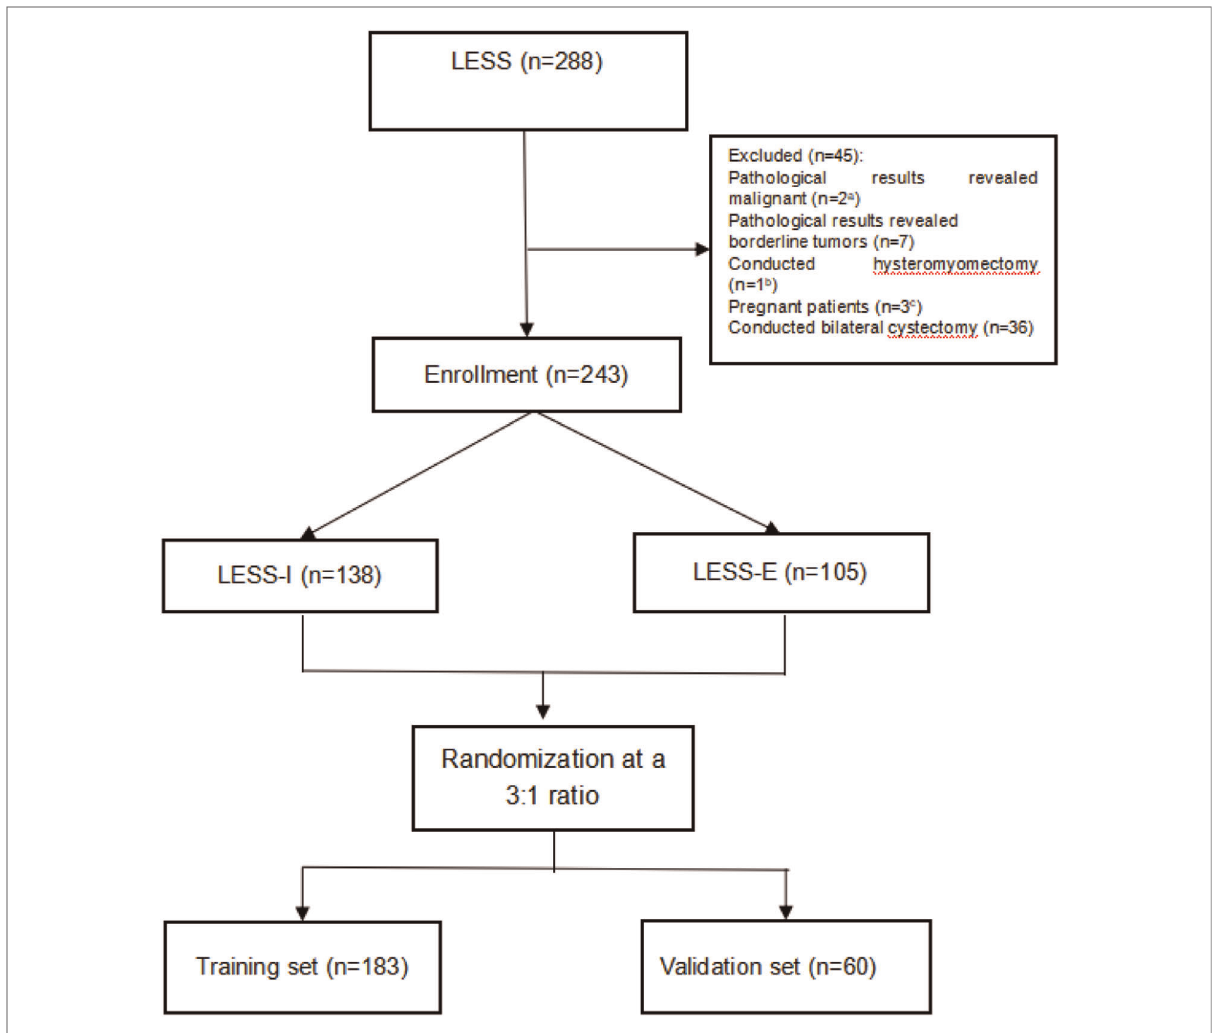
FIGURE 1 Flowchart of the training set and validation set. a, 1 of the 2 associated with bilateral cystectomy; b, associated with bilateral cystectomy; c, 2 of the 3 associated with bilateral